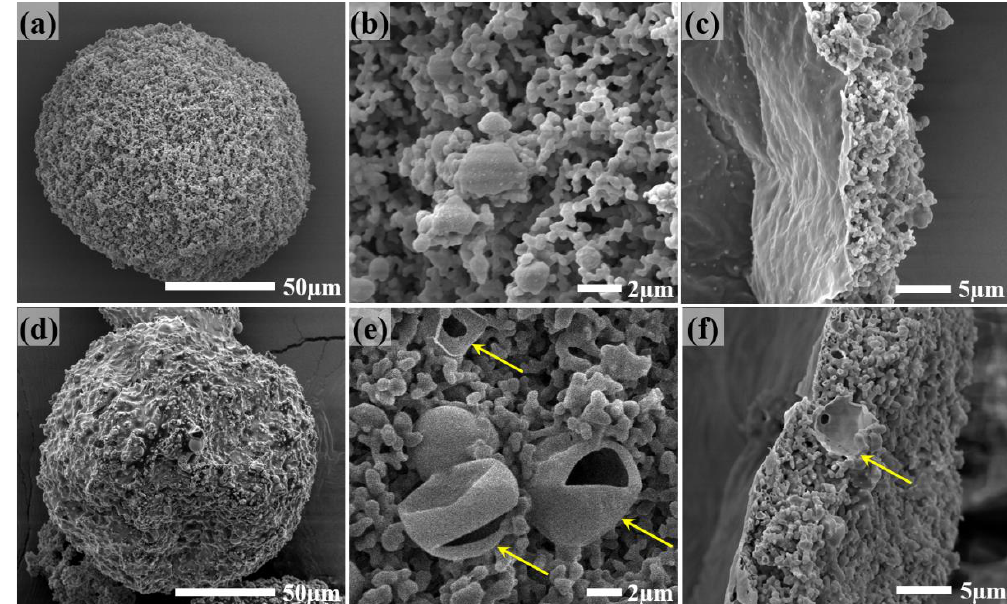
Figure 5. Appearance, surface morphology, and cross-section of the polyamine microcapsules fabricated using solvents with different polarities. ( a – c ) 50C10 – 50C16 mixed solvent, and ( d – f ) pure C16. Arrows in ( e ) and ( f ) indicate the directly exposed secondary microcapsules after fracturing during storage.